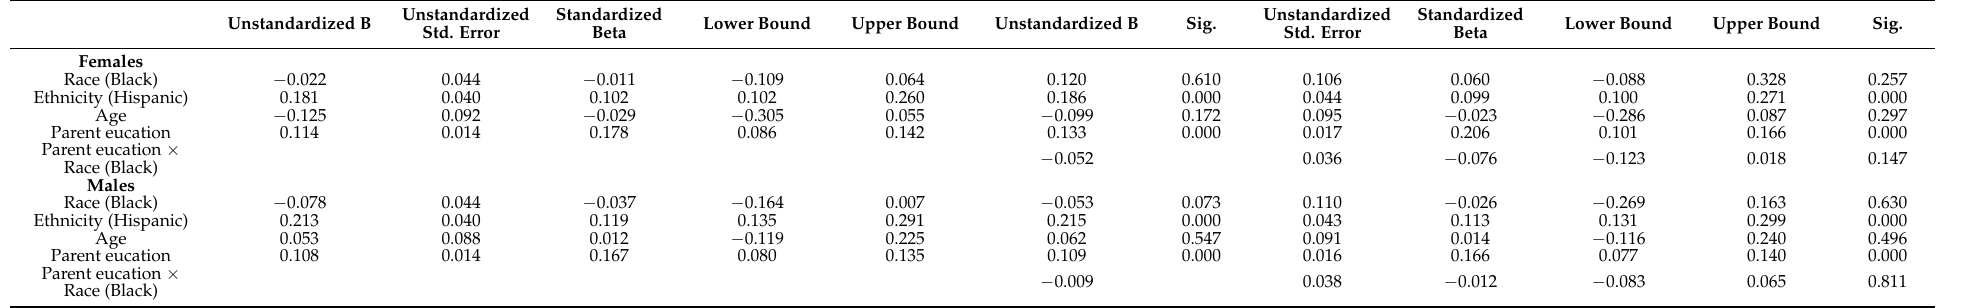
Table 5. Stratified models in male and female